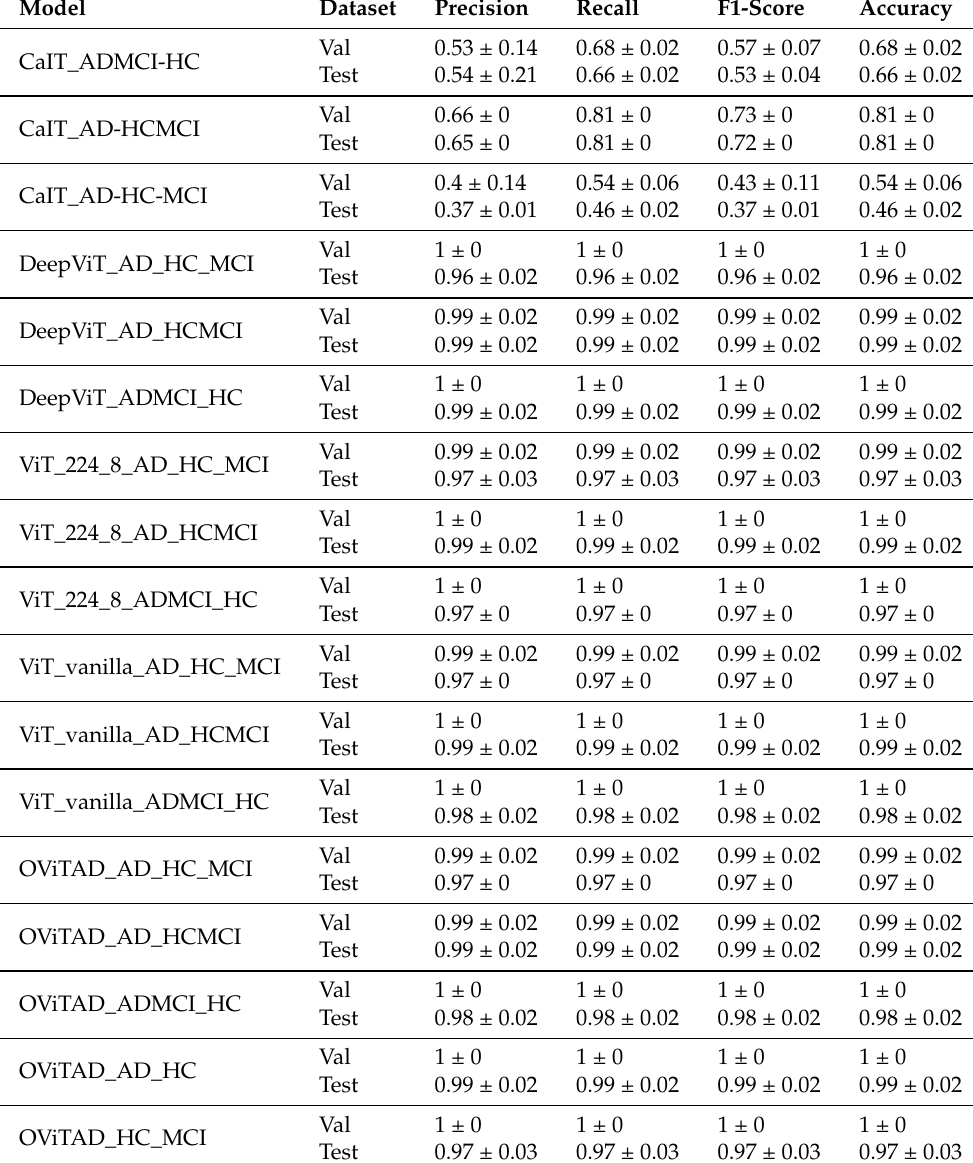
Table 2. To evaluate the performance of experiments referring to model-level results, we used the weighted average scores of subject-level results and calculated each experiment’s average and standard deviation across three repetitions for validation and test sets (random data